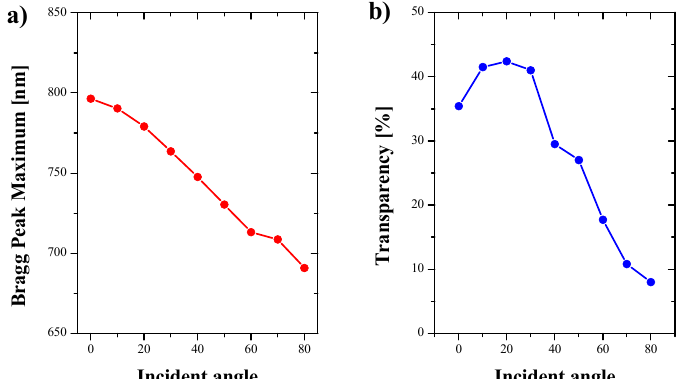
Figure 5. ( a ) Bragg peak position shifting as function of the incident angle; and ( b ) transparency data obtained from transmittance curves versus incident irradiation angle.